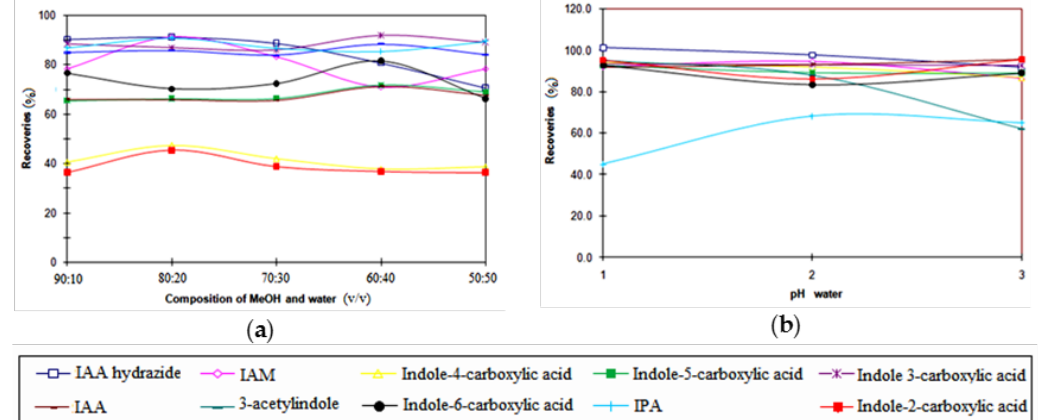
Figure 3. The effects of different methanol and water composition ( a ) in eluting solution, different pH values of water ( b ) used in conditioning and washing steps which were adjusted by formic acid, on the recoveries of indole compounds using C 18 SPE columns.